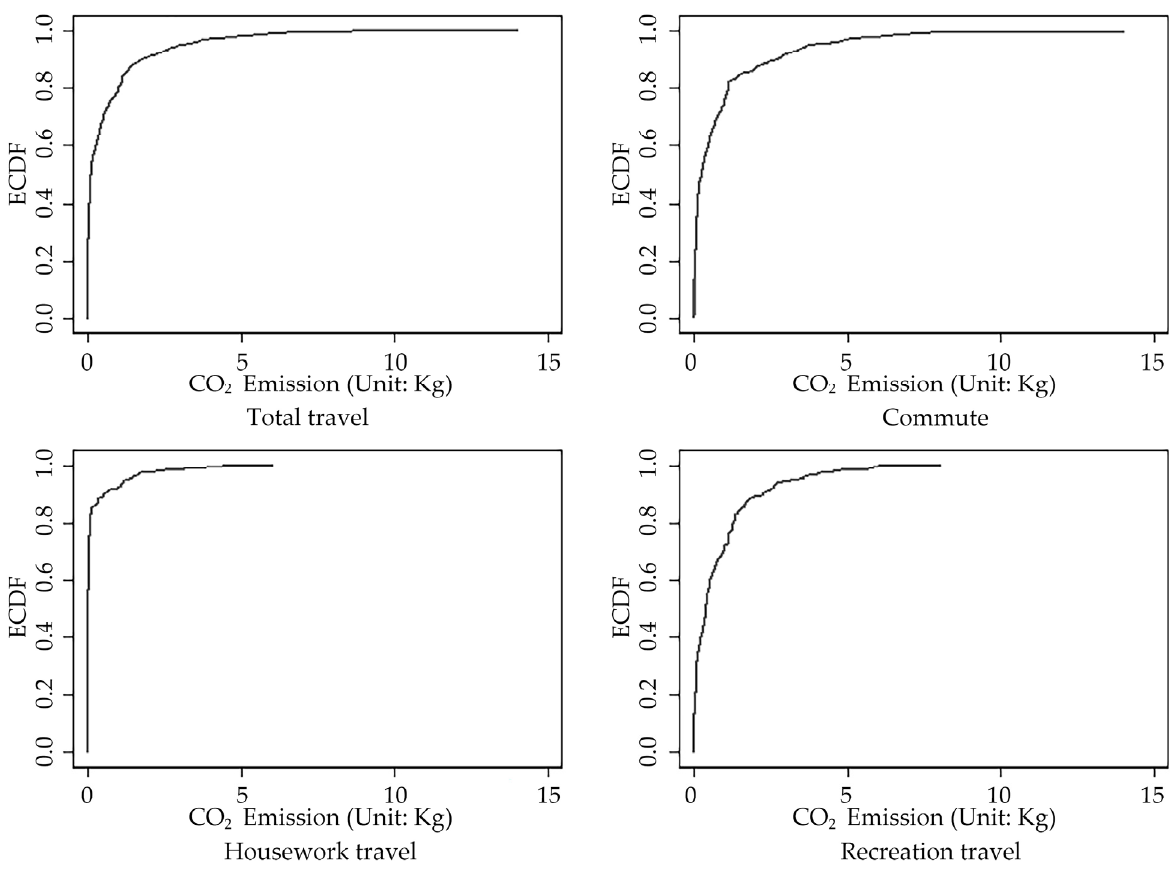
Figure 5. ECDF curves of travel-related CO 2 emissions.